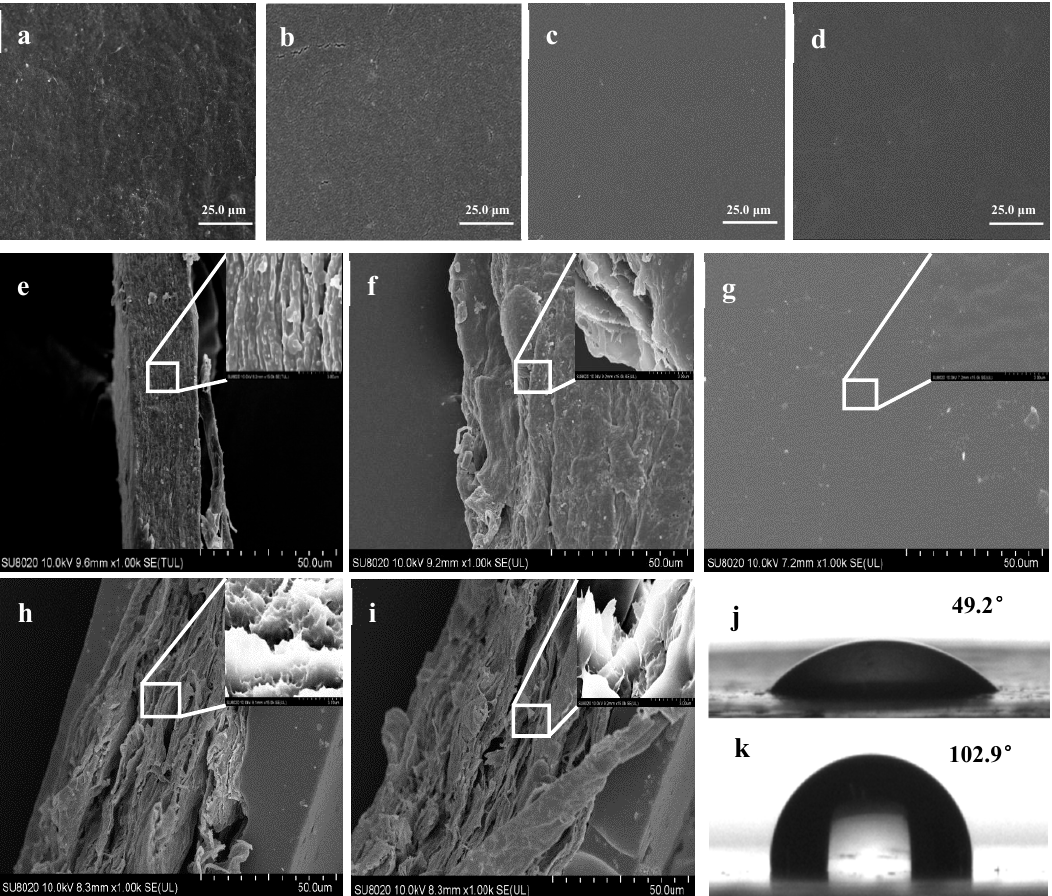
Figure 5. The apparent images of samples: ( a ) neat NFC film, ( b ) neat ANFC film, ( c ) neat ABPE-10 film, and ( d ) ANFC/ABPE-10 composite film (68% ANFC). The tensile cross-section images: ( e ) neat NFC film, ( f ) neat ANFC film, ( g ) neat ABPE-10 film, ( h ) NFC/ABPE-10 composite film, and ( i ) ANFC/ABPE-10 composite film (68% ANFC). The contact angle images of: ( j ) neat ANFC film and ( k ) ANFC/ABPE-10 composite film (68% ANFC).